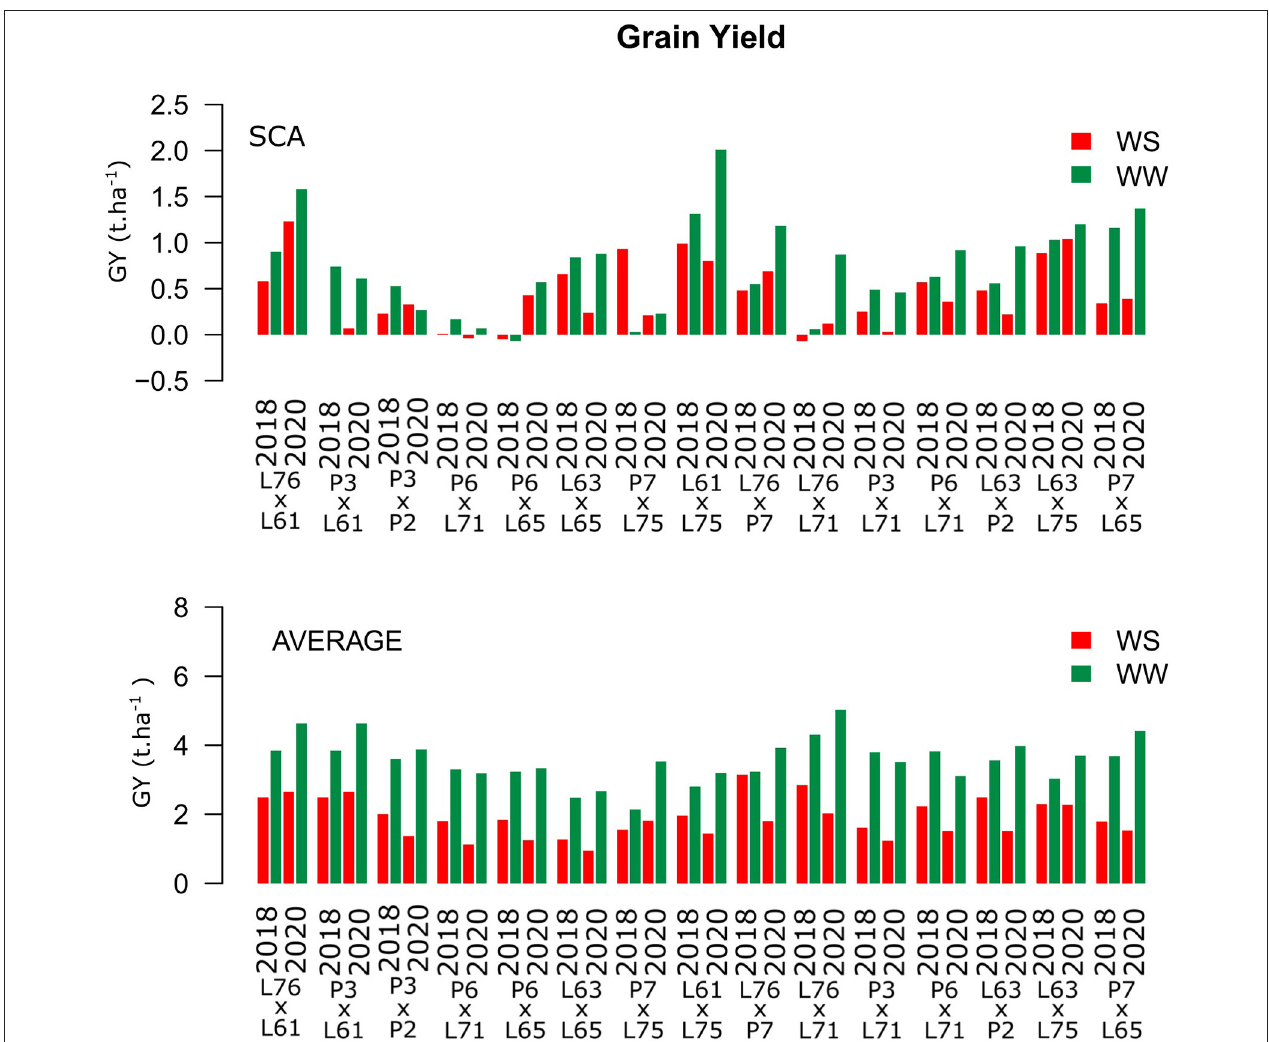
FIGURE 3 | Estimation of the specific combining ability (SCA) and GY (t ha − 1 ) mean values for popcorn hybrids evaluated under two WCs and crop seasons in 2018 and 2020. WS is represented by red bars and the WW condition is represented by dark-green bars.